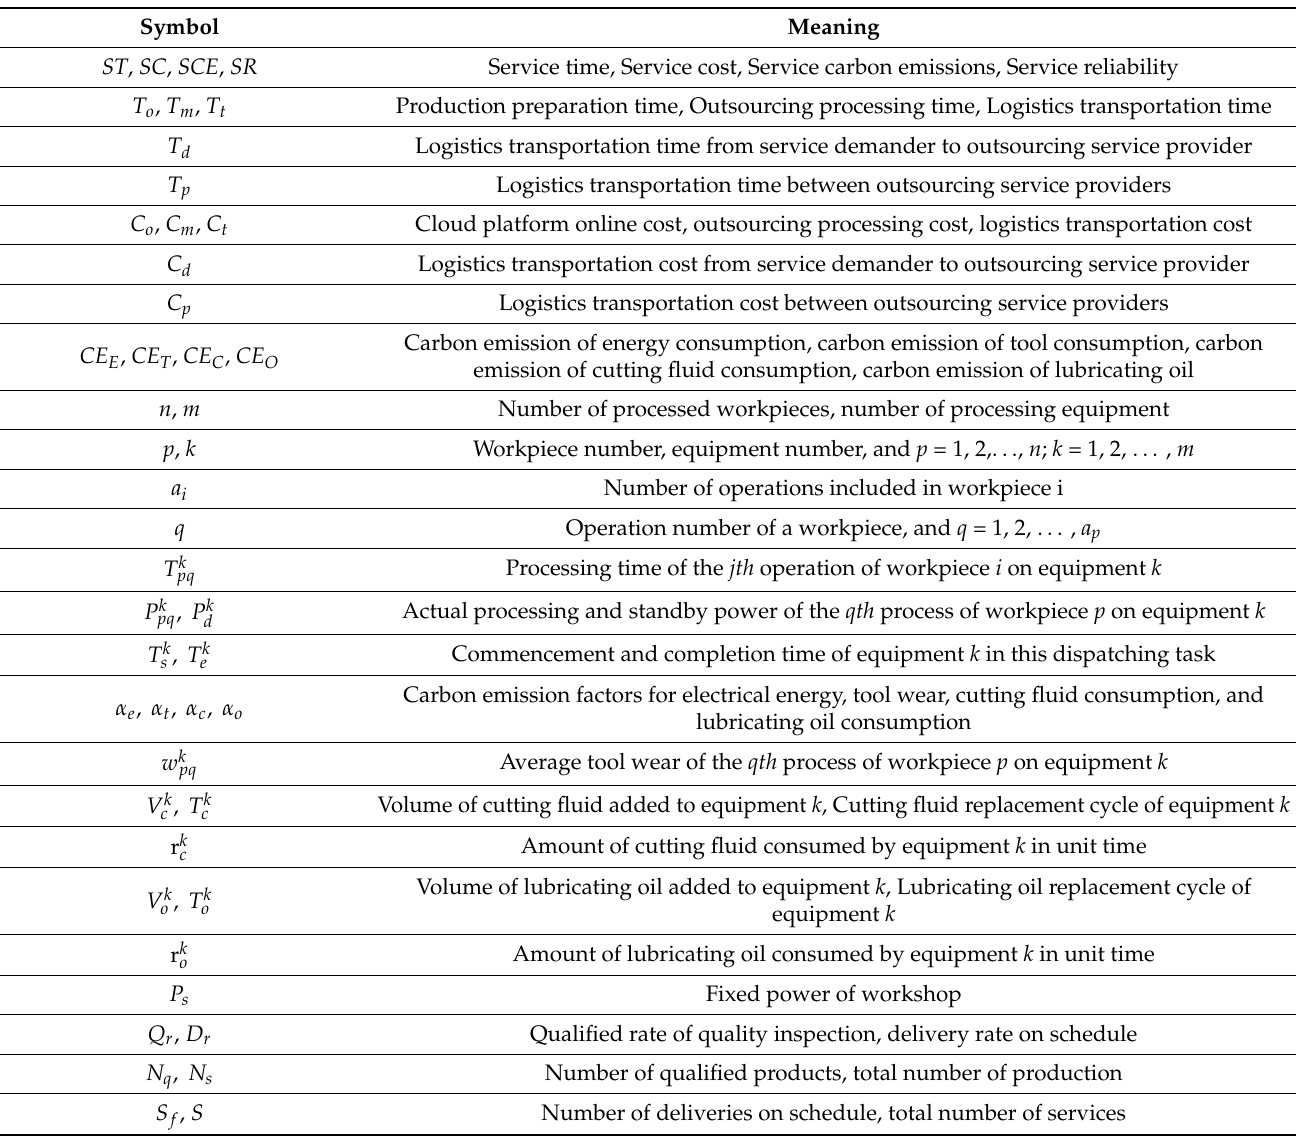
Table 2. Symbols and their